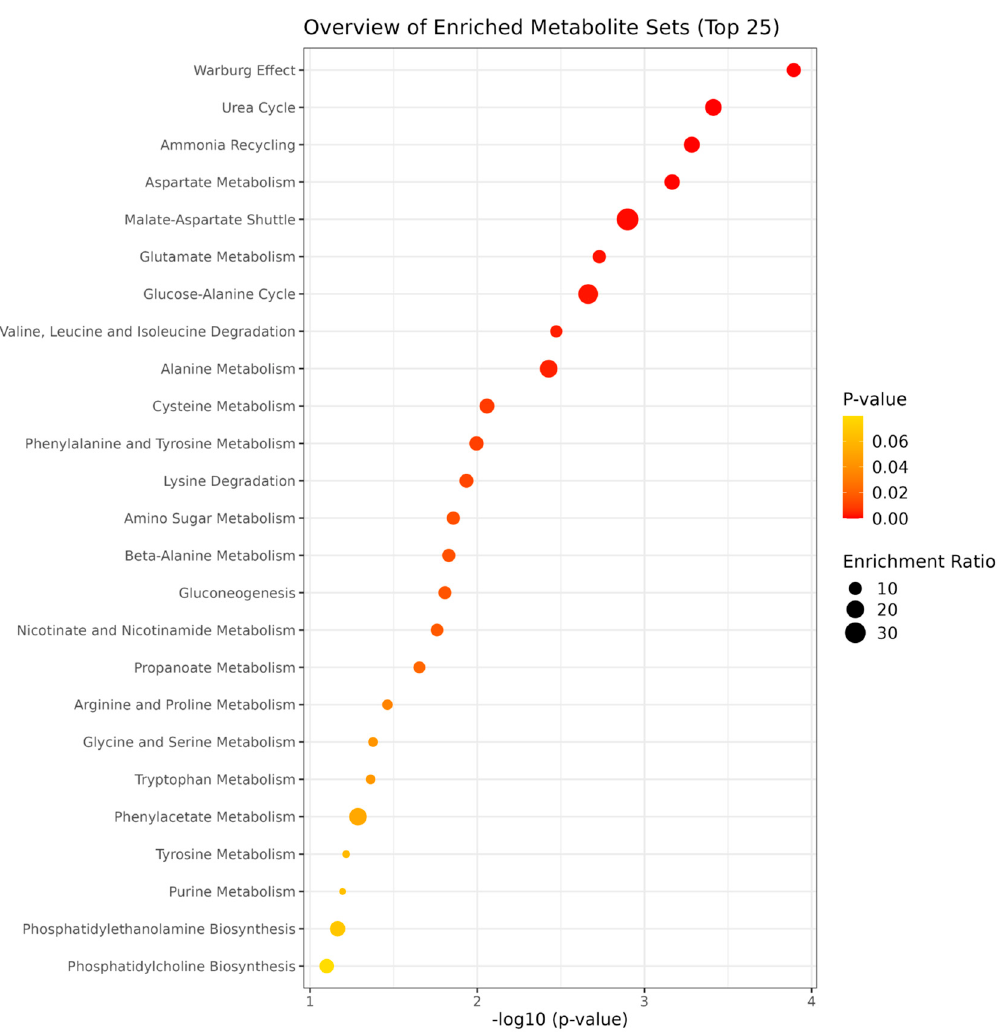
Figure 5. Metabolite set enrichment analysis of the association between maternal weight gain and offspring metabolome. The metabolite set enrichment analysis of metabolites with PLS-DA scores higher than 1 and adjusted p values < 0.05 at birth, 6 months of age, or 12 months of age. Metabolic pathways whose names are indicated are significant ( p -values lower than 0.05 after the adjustment using the Holm-Bonferroni method and False Discovery Rate) and have a pathway impact value, calculated through pathway-topology analysis, over 0. The pathways are represented as circles. The circle colour indicates the significance level, from highest (red) to lowest (white) in the enrichment analysis. The circle size is proportional to the impact value of each pathway from the topology analysis.